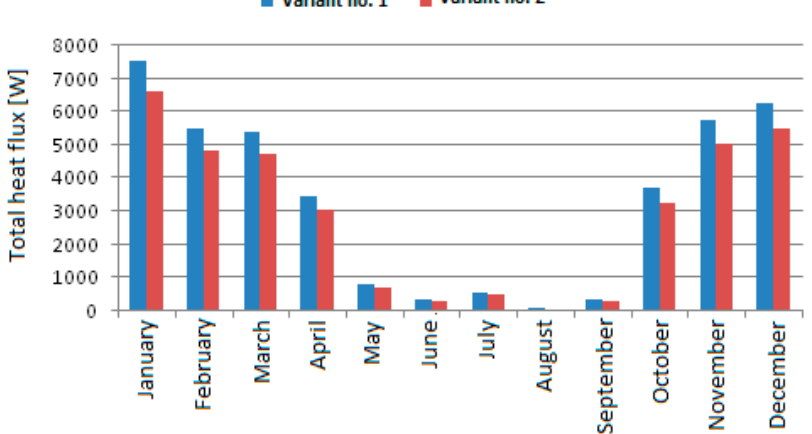
Figure 3. Flux of heat penetrating the building wall in both variants (Variant No. 1 is without BIPV; Variant No. 2 is with BIPV).